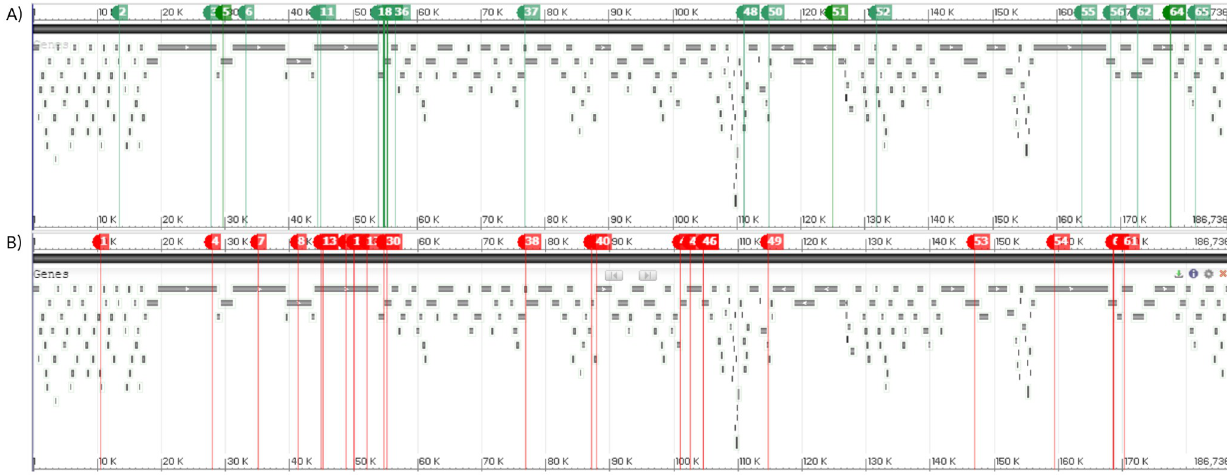
Fig 4. Locations of the mutations within the cyanophage S-PM2d genome organization. A) 33 non-synonymous and 2 synonymous early mutations (green markers) detected in the cyanophage populations on day-39 of infection experiment. B) 30 non-synonymous late mutations (red markers) detected on day-500. Numbers on markers correspond to the numbering of mutations in Fig 2. Image generated using the NCBI Sequence Viewer version 3.46 [27].